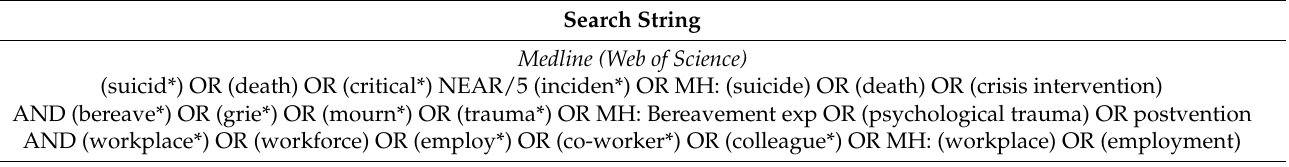
Table A1. Example of a search string used to identify records.